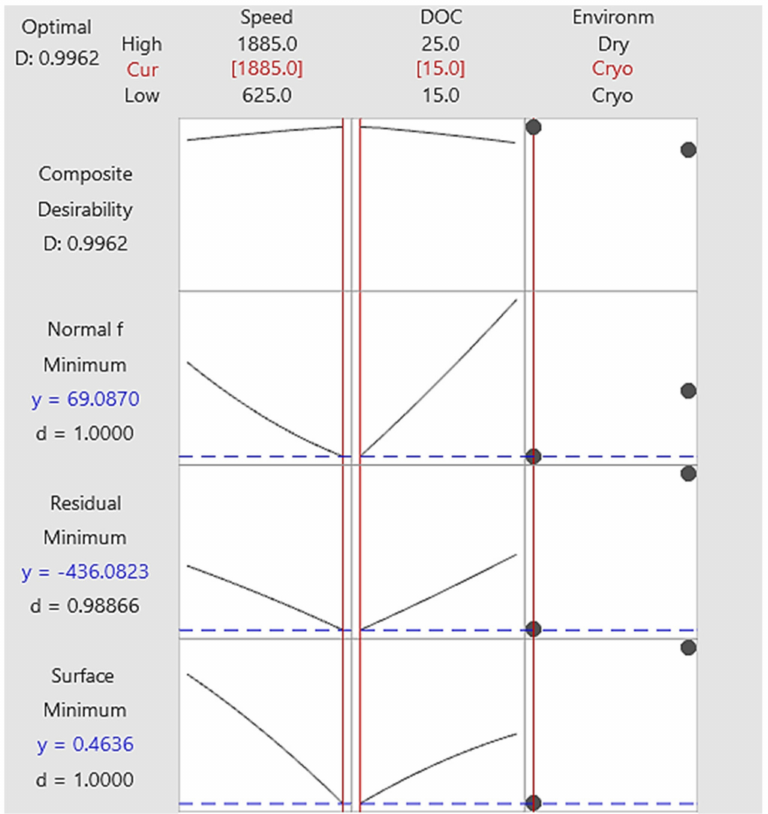
Figure A1. Multi-objective optimization plot for the grinding of DMLS maraging steel under different environments.